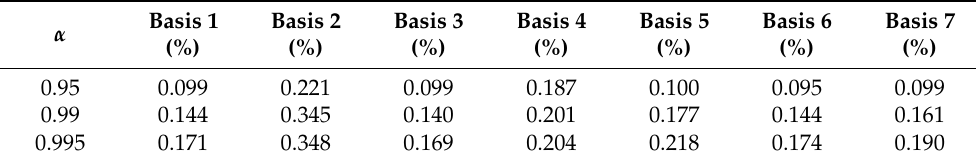
Table 4. The rRMSE of estimated VaR in Portfolio 2.